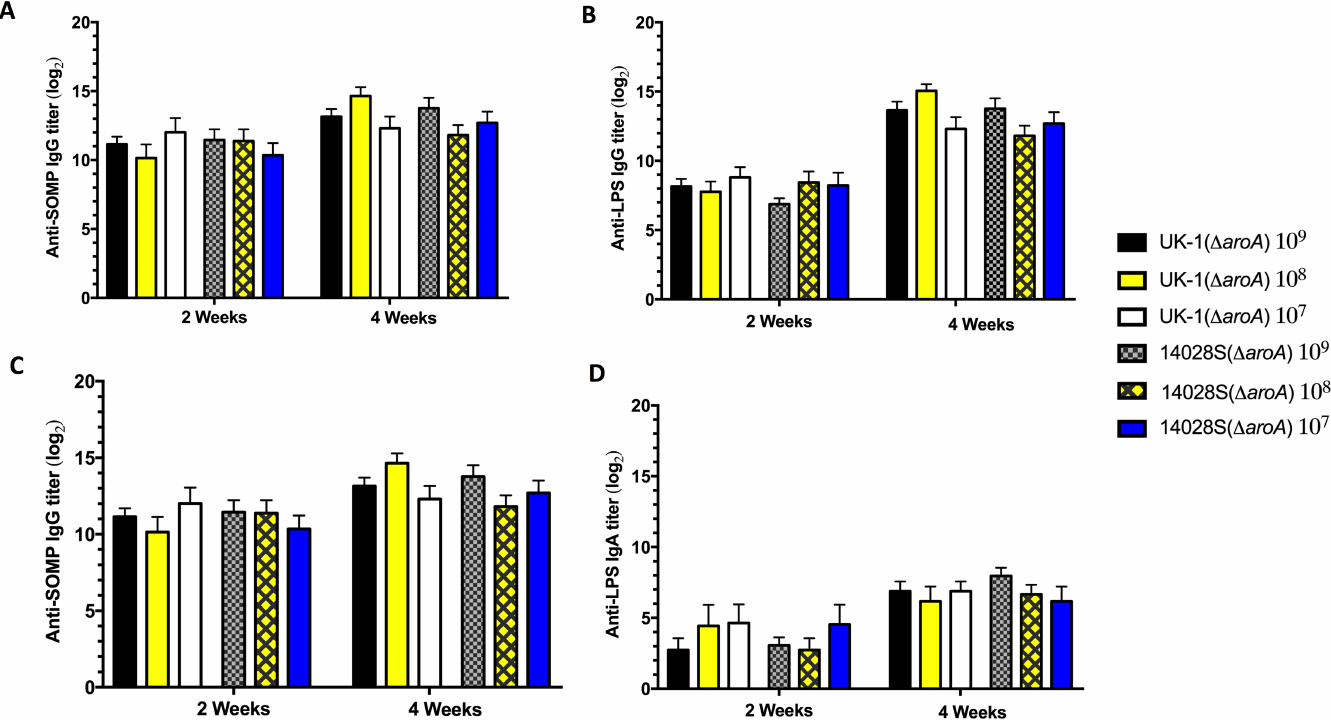
Fig 2. Anti-SOMP and anti-LPS antibody responses in mice. Serum IgG responses to (A) SOMP, and (B) LPS as well mucosal IgA responses to (C) SOMP, and (D) LPS were determined by ELISA at 2 and 4 weeks after oral immunization in sera and vaginal washes from BALB/c mice ( n = 6) orally immunized with UK-1( Δ aroA ) or 14028S( Δ aroA ) at doses 1x10 9 , 1x10 8 or 1x10 7 CFU. No statistically significant difference was observed between vaccine groups.